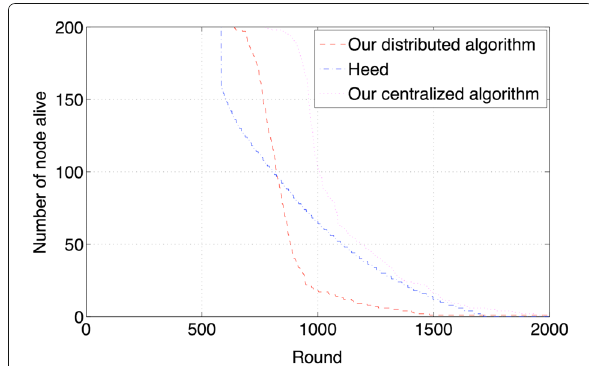
Fig. 6 Number of nodes alive over time. Our algorithm can improve the network lifetime (the difference between the time that the first node dies and the time that the last node dies) compared to